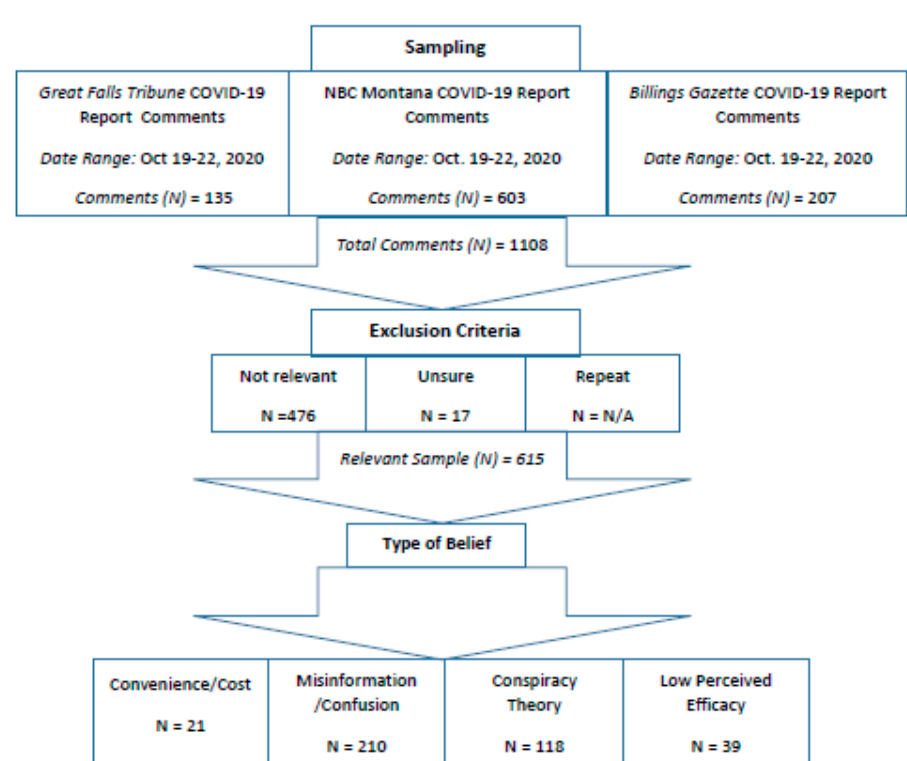
Figure 1. Sampling diagram of Facebook comments. Comments were sorted by the number of responses, from the most to least interactive comments. After sorting, the first 100 comments from each news source were taken each day of the week.